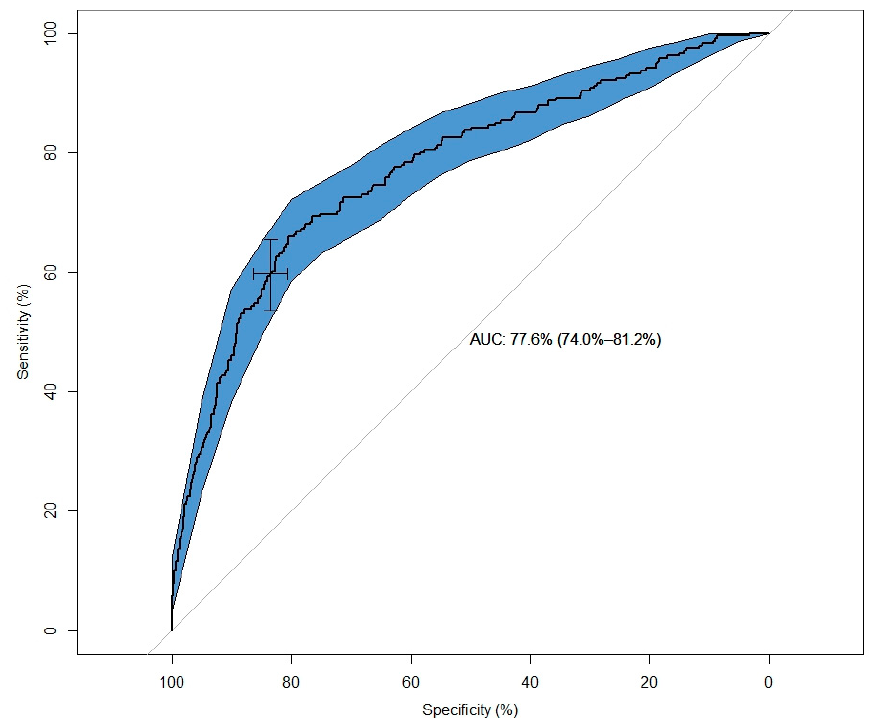
Figure 3. ROC for prediction of an IgM positive serological